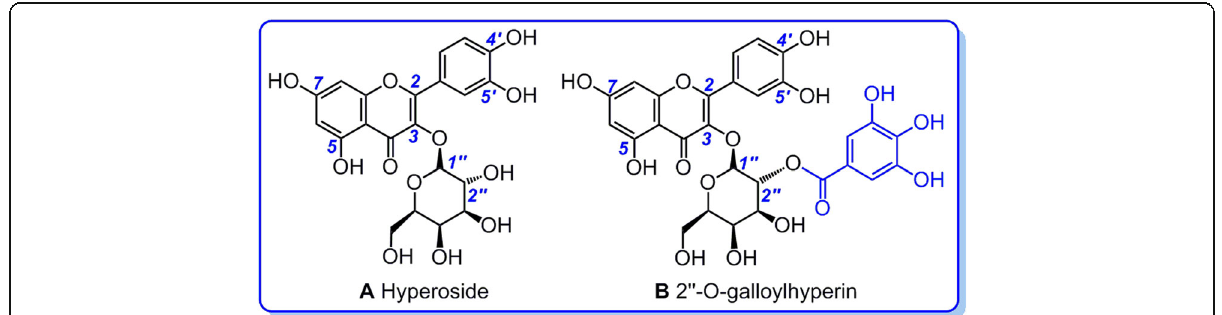
Fig. 1 Structural formulae of hyperoside ( a ) and 2 ′′ -O-galloylhyperin ( b ) (hyperoside is also called as